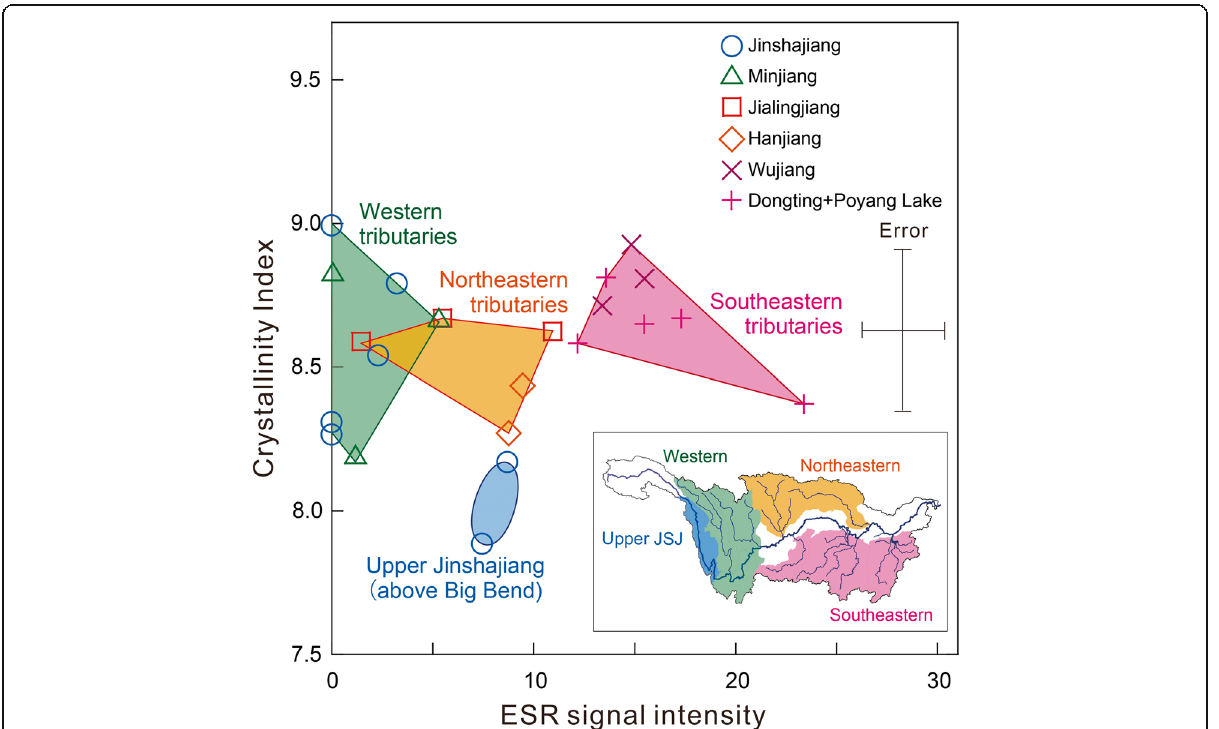
Fig. 4 ESR signal intensity vs. CI plot of quartz in the fine silt fraction of the riverbed samples from the major tributaries of the Yangtze River from Saito et al.